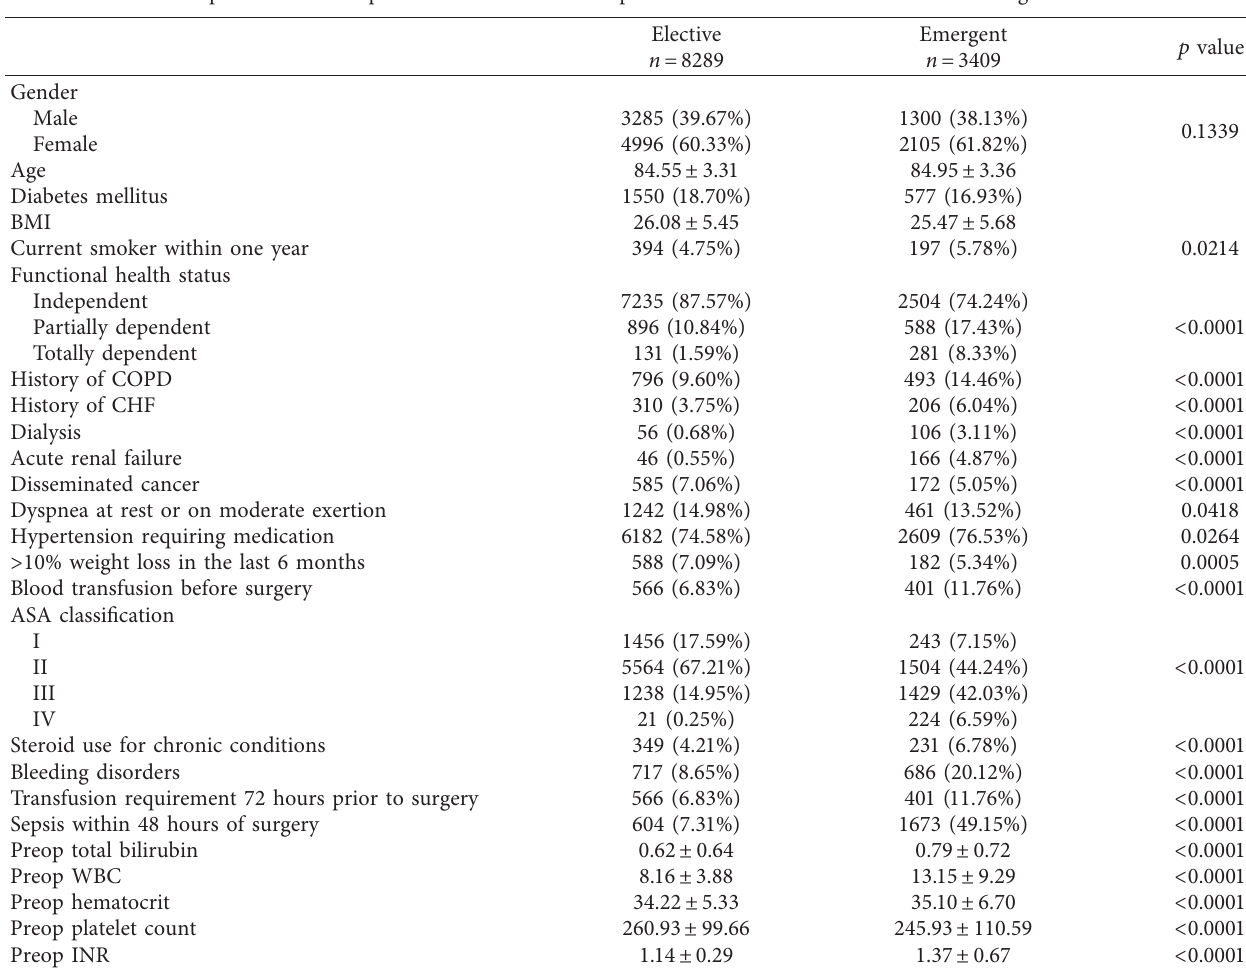
Table 2: Preoperative baseline patient characteristics’ comparison of elective colectomies versus emergent